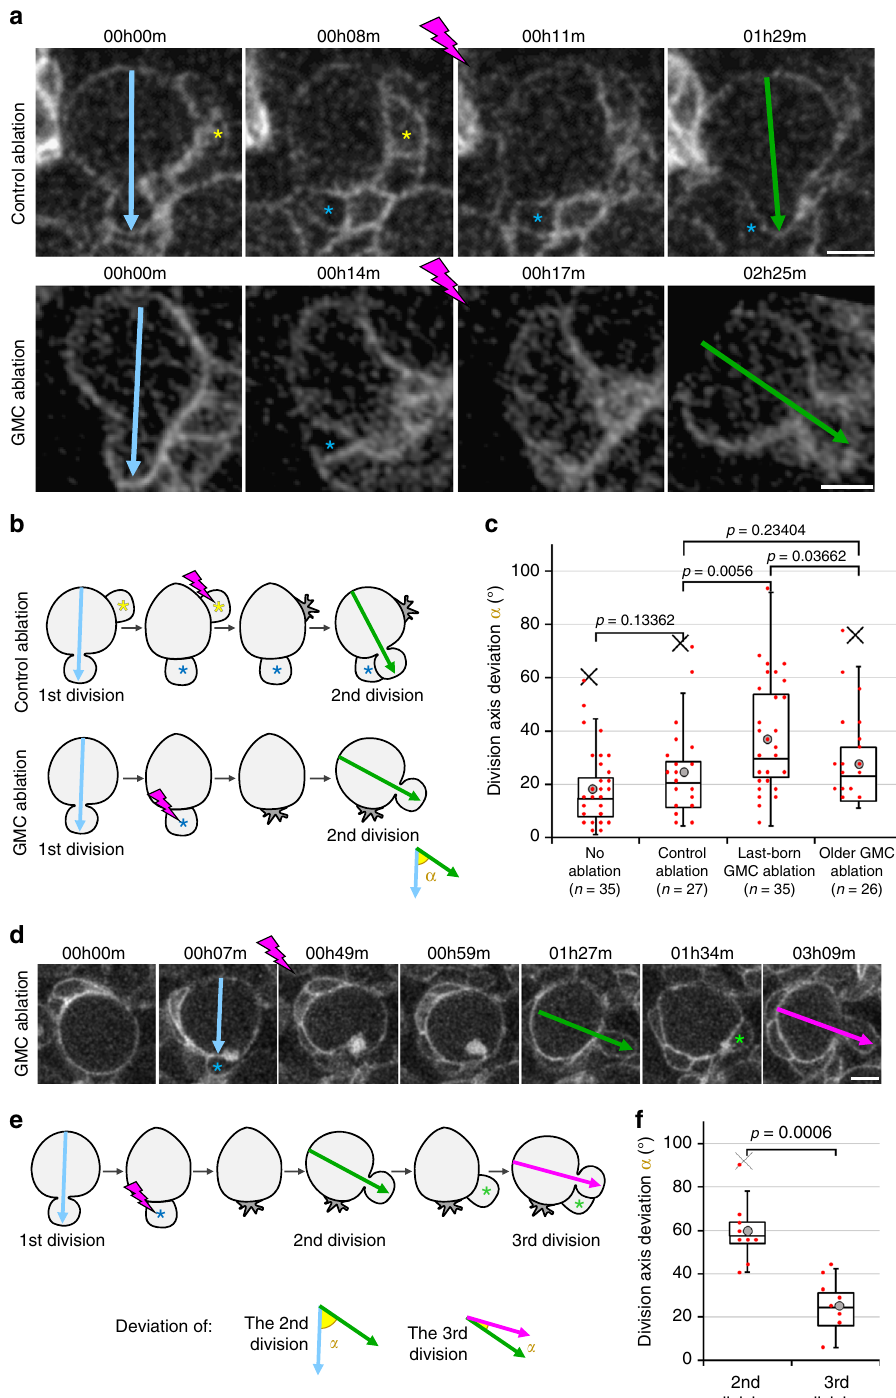
Fig. 2 GMC ablation disrupts division axis maintenance. a Two successive divisions of NBs expressing worniu -GAL4-driven PH::GFP, the second division following the control ablation (upper panels) of a NB-neighbouring cell (yellow asterisk) away from the last-born GMC (blue asterisk) or following GMC ablation (lower panels) are shown. The ablation takes place between the two frames separated by a lightning symbol. Arrows: division axis. b Schematic of the ablations and angle measurements. c Deviation of the division axis following no ablation (Average angle: 18 ± 14°, n = 35), control ablation (23 ± 16°, n = 27), last-born GMC ablation (36 ± 20°, n = 35; also shown in Figs. 3c and 5c) or older GMC ablation (27 ± 16°, n = 26). Data from ten independent experiments. For examples of control or last-born GMC ablations resulting in a high misalignment of the second division axis, see Supplementary Movies 6 and 7. d Three successive divisions of NBs expressing worniu -GAL4-driven PH::GFP. The ablation takes place between the two frames separated by a lightning symbol. Blue asterisk: GMC prior to ablation, green asterisk: new last-born GMC. Arrows: division axis. e Schematic of the angles α measured from the movies shown in the previous panel. f Deviation α of the second (59 ± 14°, n = 9) and third (25 ± 11, n = 9) divisions described in the two previous panels. Data from fi ve independent experiments. Scale bar in all panels: 5 µ